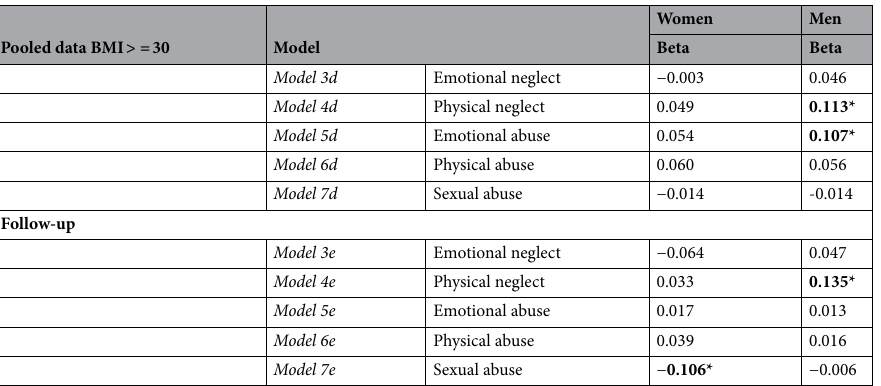
Table 6. Results of the multivariable regression models of the sensitive analysis for follow-up. In the obese group, the strength of childhood trauma in women became even weaker and less relevant. However, in the follow-up, we could identify sexual abuse as predictor for a lower WHtR. In men, physical neglect remained the most relevant predictor, however, emotional abuse was significant in the baseline as well. + p < = 0.1, *p < = 0.05, **p < = 0.01, ***p < = 0.001. Statistical significant results are highlighted in